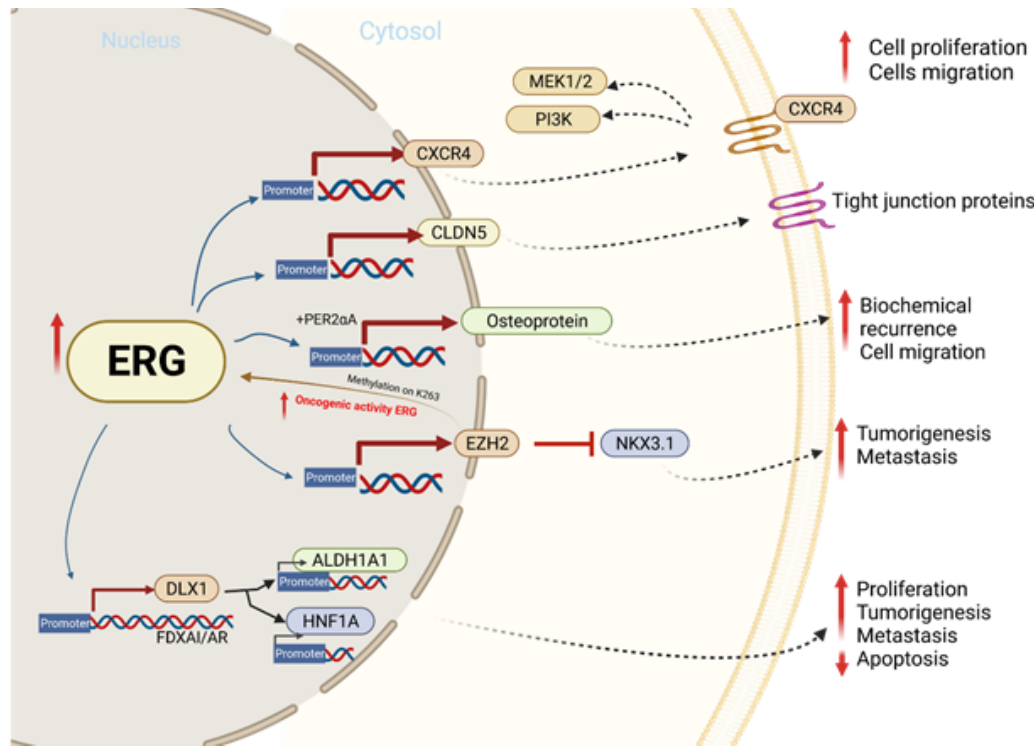
Figure 3. The molecular mechanism involved in ERG overexpression and related outcomes in tumor cell proliferation, migration, invasion, and metastasis.